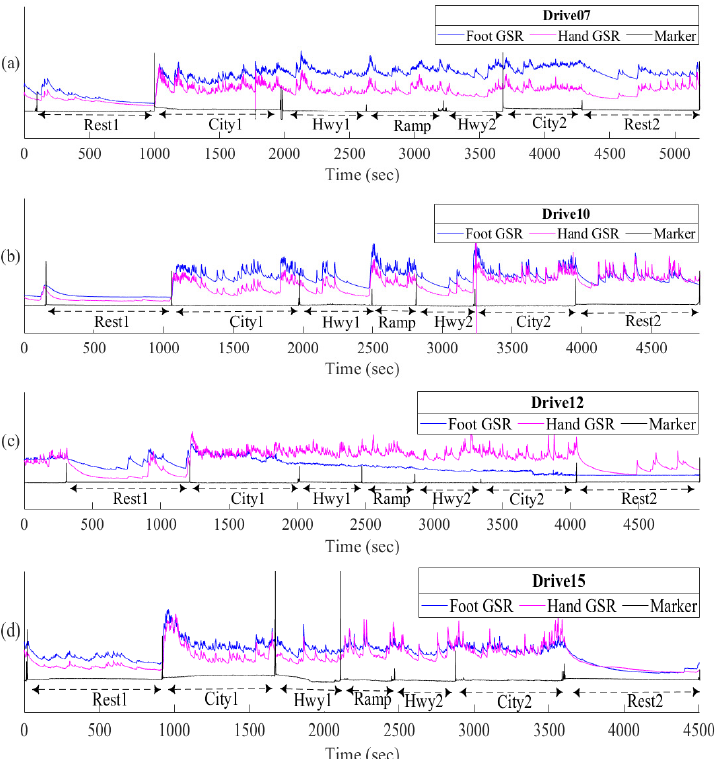
Figure 5. GSR signals and marker signals of the six driving sections of Drive07 \ 10 \ 12 \ 15: ( a ) GSR and marker signals of Drive07; ( b ) GSR and marker signals of Drive10; ( c ) GSR and marker signals of Drive12; ( d ) GSR and marker signals of Drive15. The foot GSR signal of Drive12 was inconsistent with the hand GSR signal, and the study referred to the hand GSR signal.